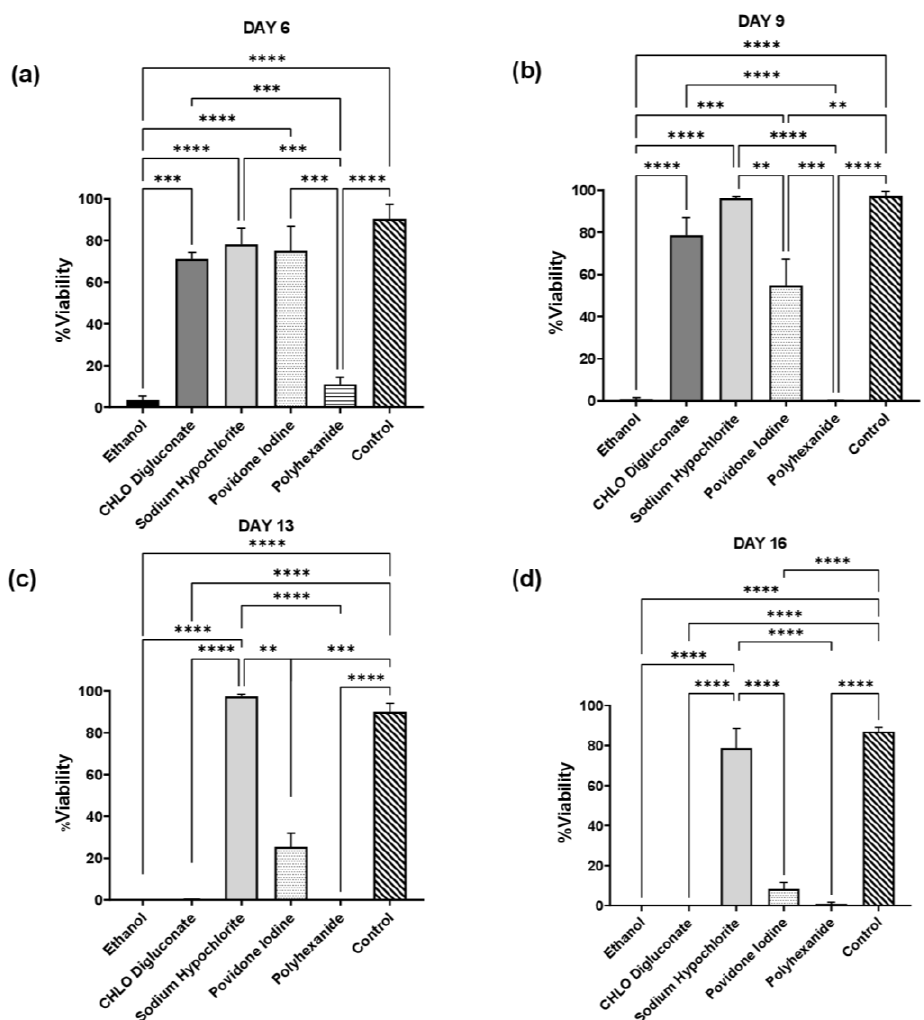
Figure 3. Statistical analysis of cell viability test for each antiseptic treatment group and control. Analysis in day 6 ( a ), day 9 ( b ), day 13 ( c ), and day 16 ( d ). n =3. Significances were represented as ** p < 0.01; *** p < 0.001; **** p < 0.0001 .